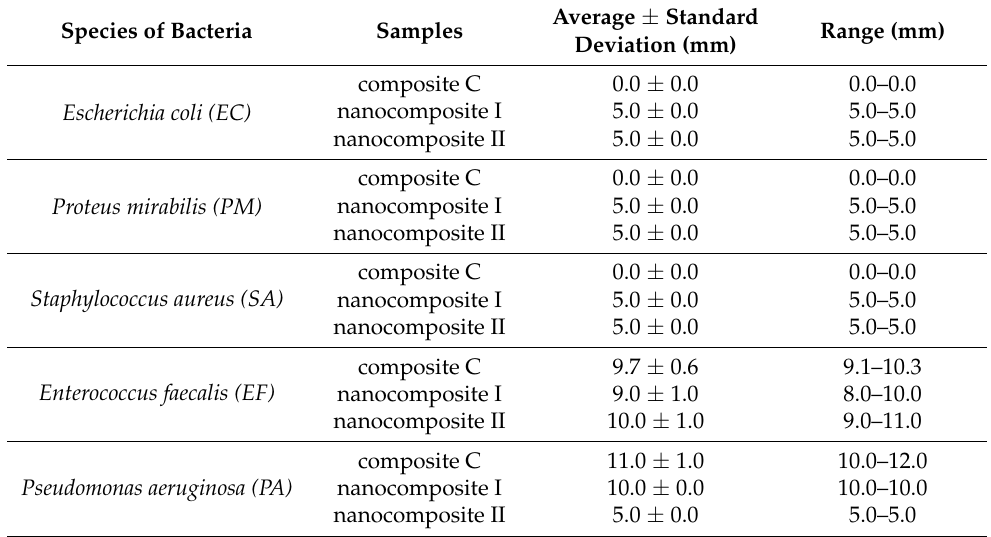
Table 8. Diameter of growth inhibition zone on thin composites: average and standard deviation. Species of